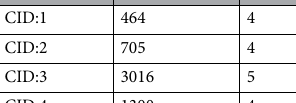
Table 5. LD50 values of the selected compounds and their respective classes.